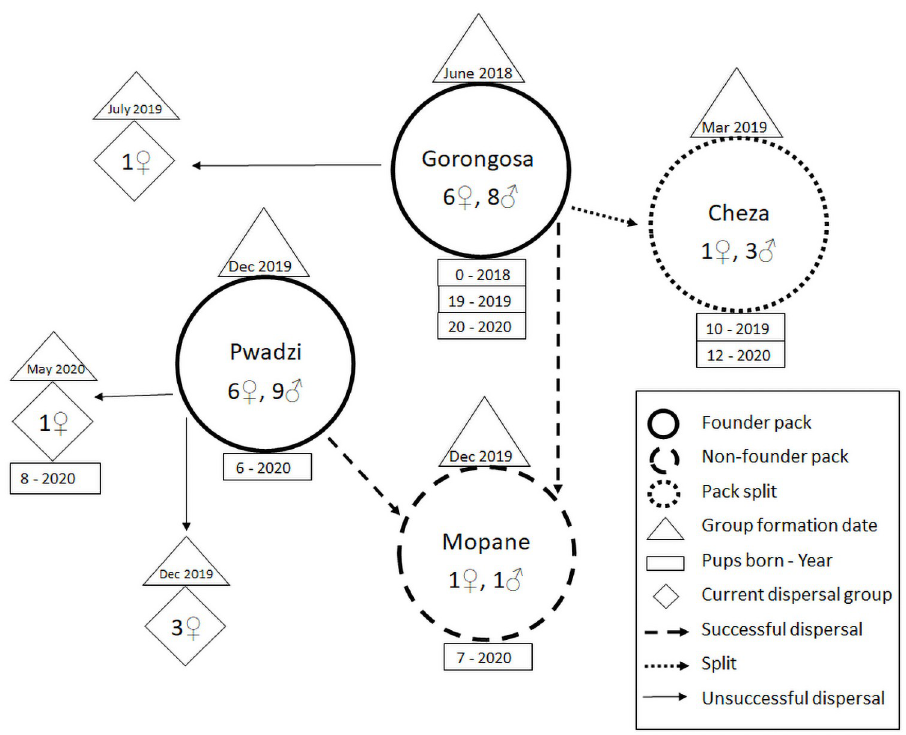
Fig 2. Group association dynamics of the reintroduced wild dog founders in Gorongosa National Park between June 2018 and September 2020. The reintroduction of two founder packs (Gorongosa and Pwadzi) resulted in two further pack formations, two successful dispersals and three ongoing dispersal events (one of these is a female with pups she had after dispersing). The number of males and females in Gorongosa and Pwadzi packs show the pack size at the time of